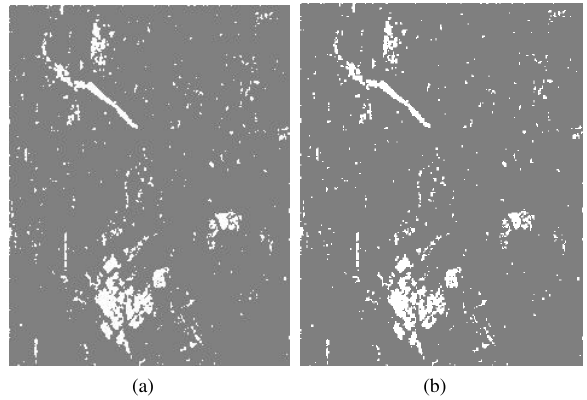
Figure 3: HLT statistic scalar feature images relating to the data set. (a) tr ( X − 1 Y ) . (b) tr ( Y − 1 X ) . Color legend: white, high